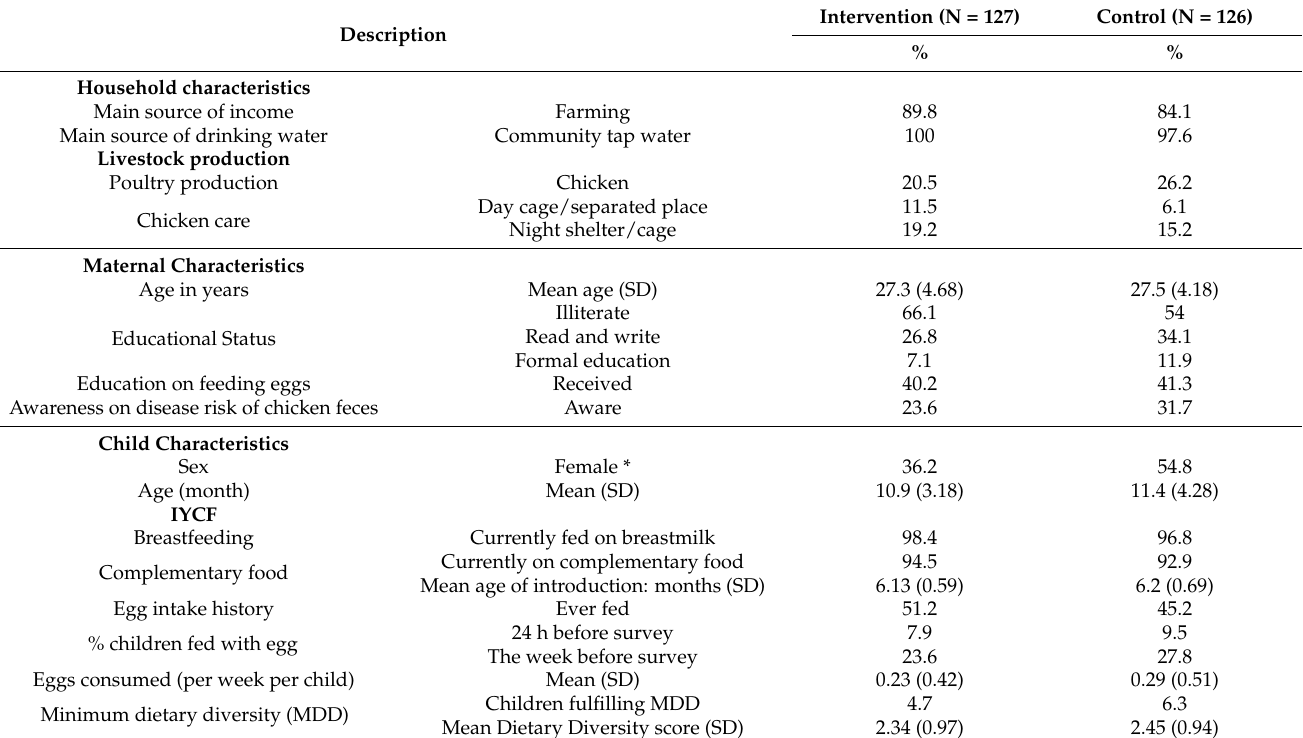
Table 1. Baseline socio-economic and demographic characteristics and IYCF